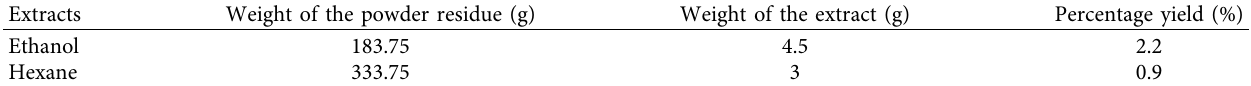
Table 1: Percentage yield of the Artocarpus heterophyllus crude ethanolic and hexane seed extract. Extracts